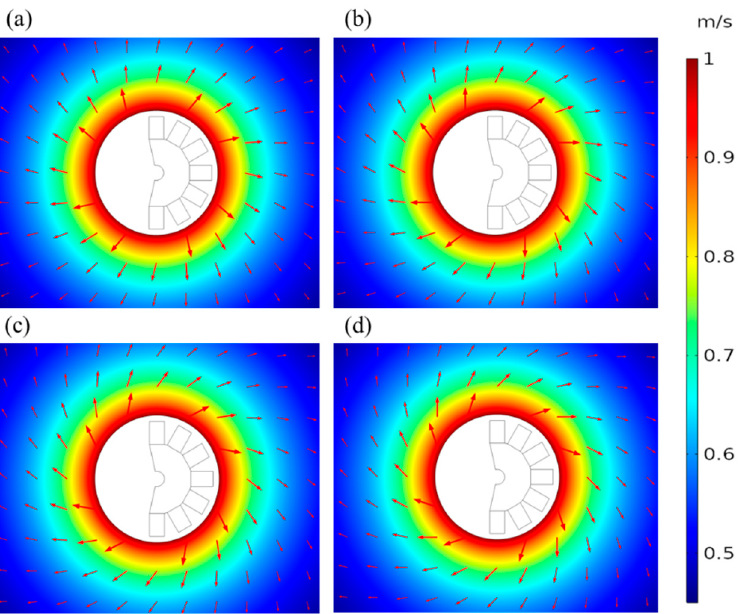
Figure 10. Air distribution around the drum at different velocities when V 0 = 1.0 m/s: ( a ) 3 rad/s, ( b ) 6 rad/s, ( c ) 9 rad/s, and ( d ) 12 rad/s.